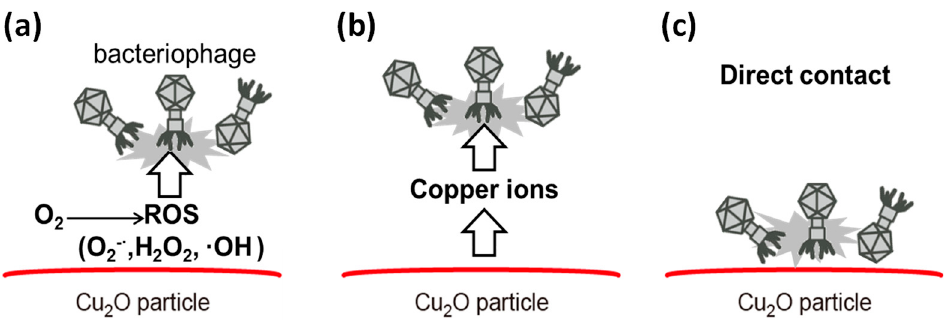
Figure 2. Possible mechanisms of the antiviral activity of Cu 2 O: ( a ) reactive oxygen species (ROS), ( b ) leached copper ions, and ( c ) direct contact with the surface [34].